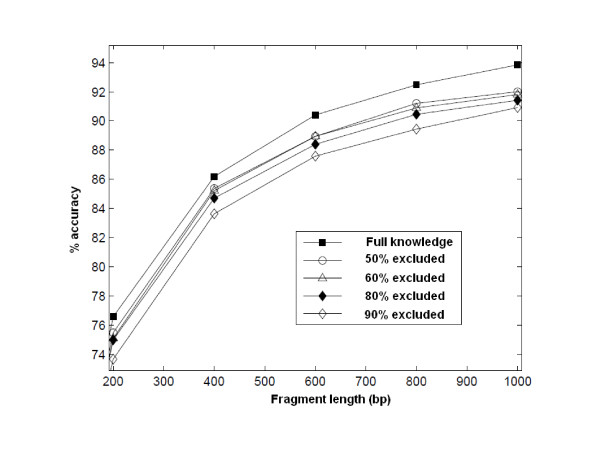
Classification accuracy for partial genome knowledge. Classification accuracy performance with varying available coverage of training genomes. RAI profiles are built using the entire genome and fragments of genomes covering 50%, 40%, 20%, and 10% of the genome. The decrease in the classification performance due to incomplete training data coverage was not significant, and classification capability was conserved.